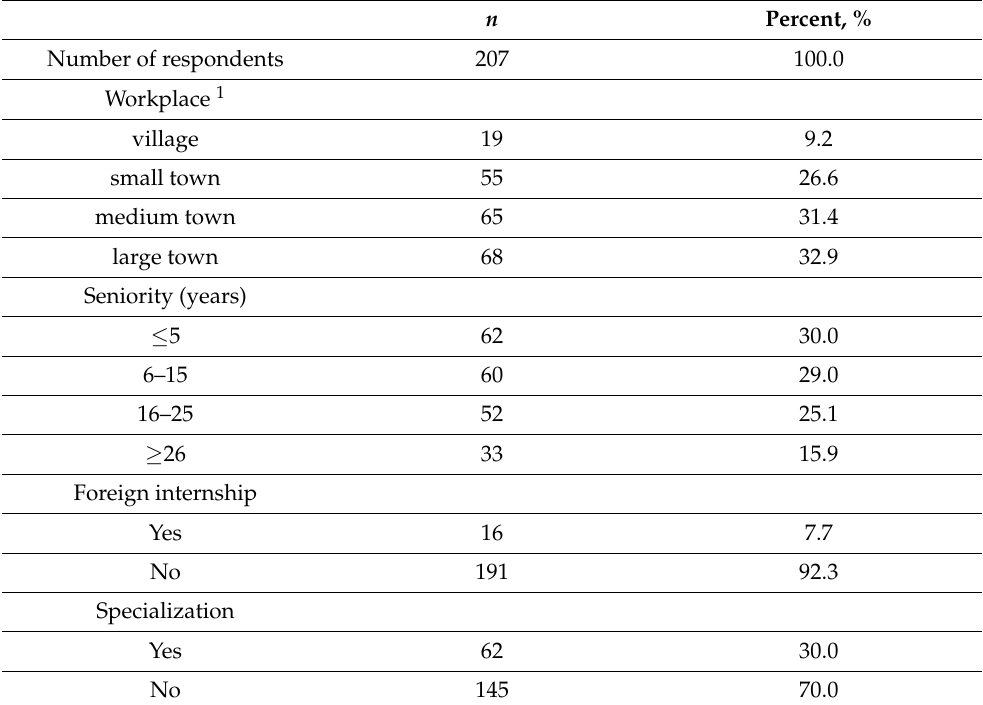
Table 1. The characteristics of